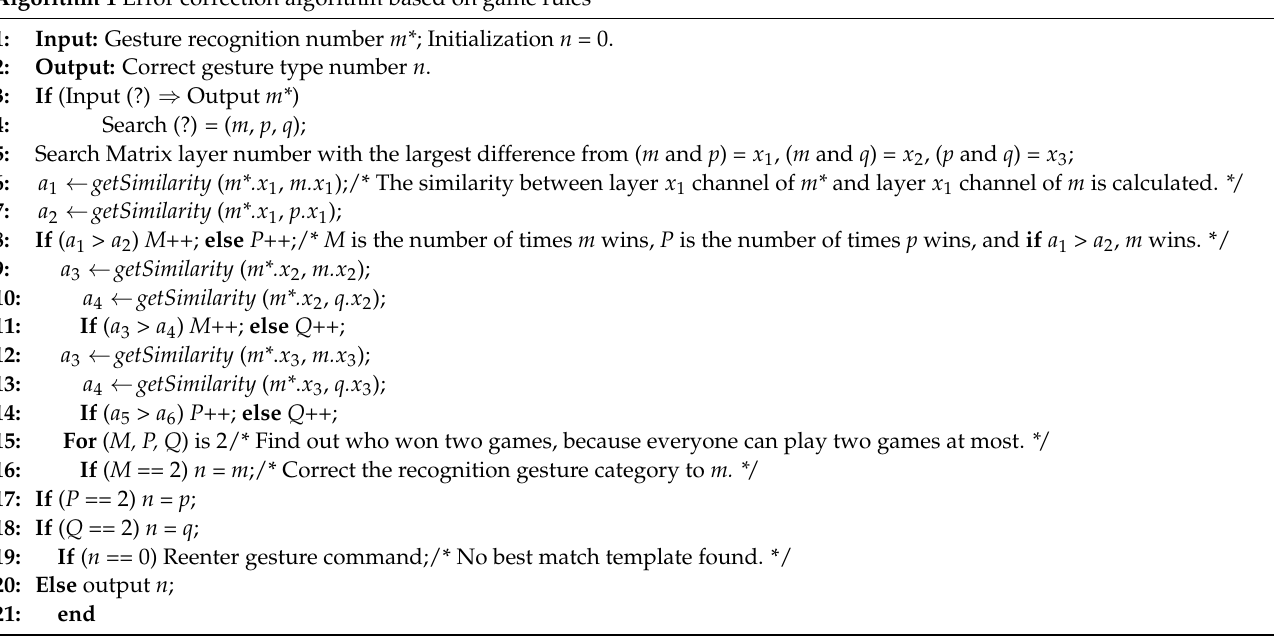
Algorithm 1 Error correction algorithm based on game